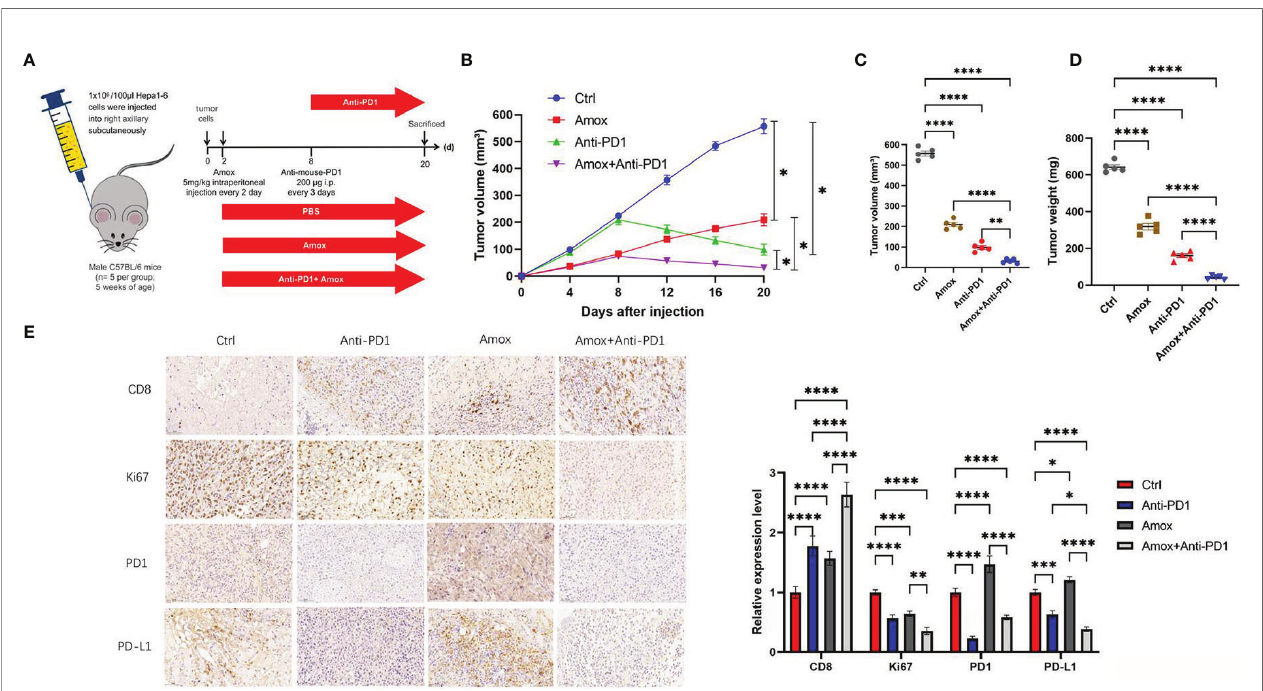
FIGURE 8 | Amoxapine worked as an effective means to treat HCC and improved the sensitivity of anti-PD1 therapy. (A) Schematic diagram of animal experiment. we injected Hepa1 – 6 cells in C57BL/6 mice. (B – D) The volume (B, C) and weight (D) statistics of subcutaneous tumors in the respective groups (PBS, amoxapine, anti-PD1, amoxapine + anti-PD1). (E) Immunohistochemistry result of CD8, Ki67, PD1, and PD-L1 expression in the respective groups. Scar bar, 50 um. * P < 0.05; ** P < 0.01; *** P < 0.0001; **** P <